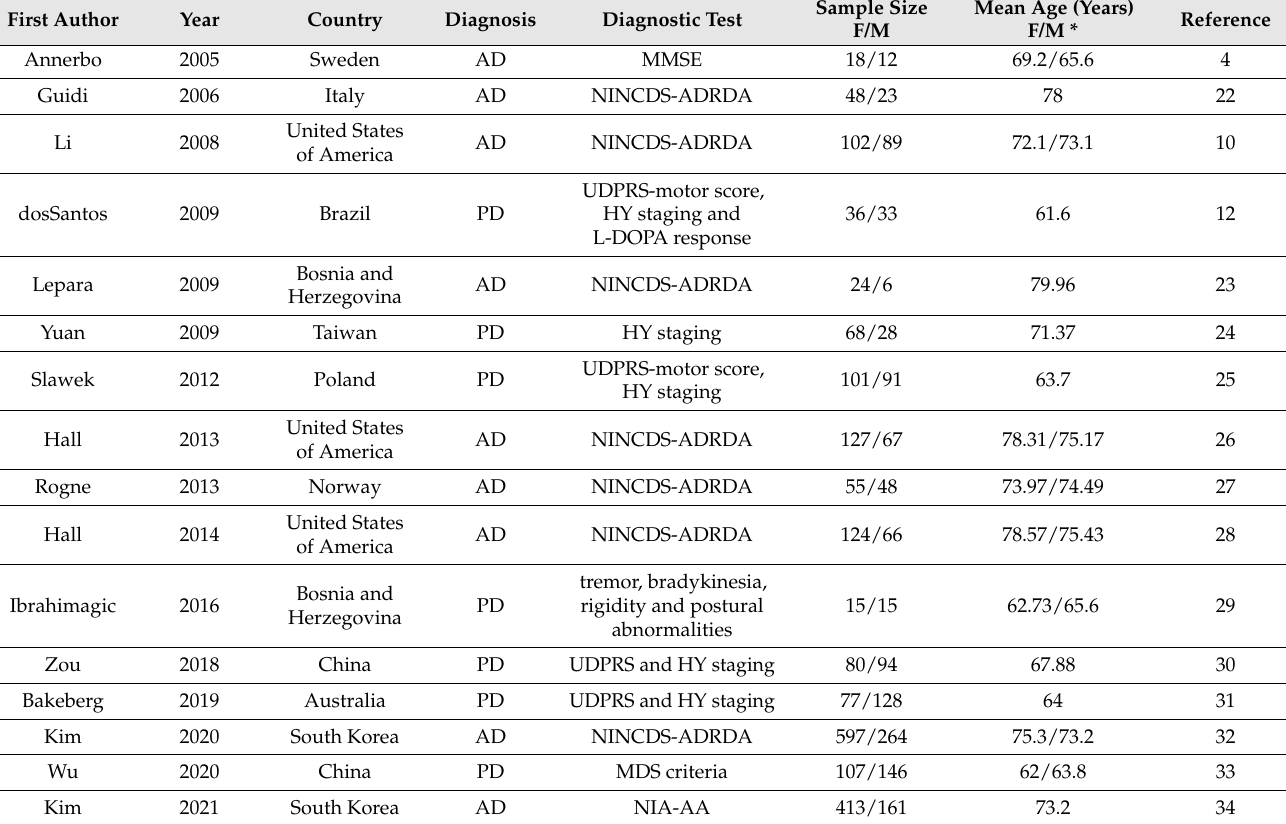
Table 1. Characteristics of Studies Included in the